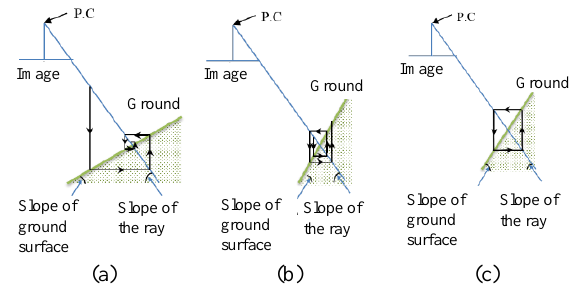
Figure 1. (a) Common method for solving Ray-DSM intersection problem, (b and c) its convergency problems